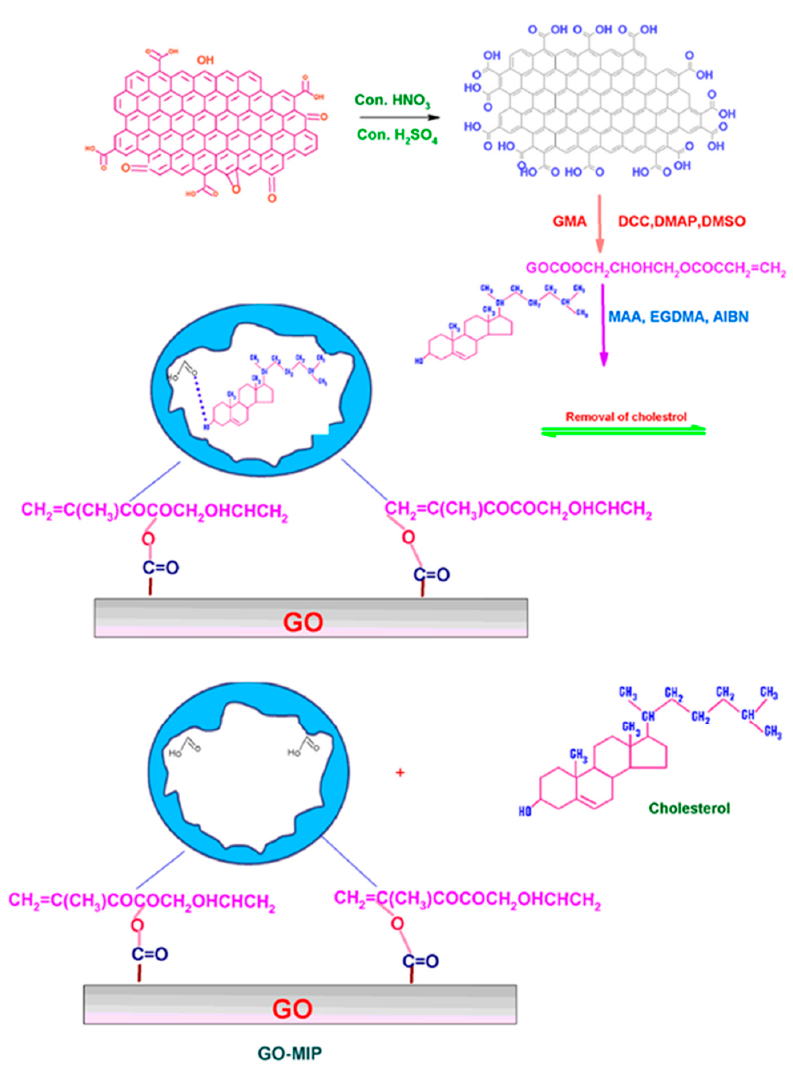
Figure 12. Schematic representation of the formation of GO-MIP. Reprinted with permission from Ref. [79].